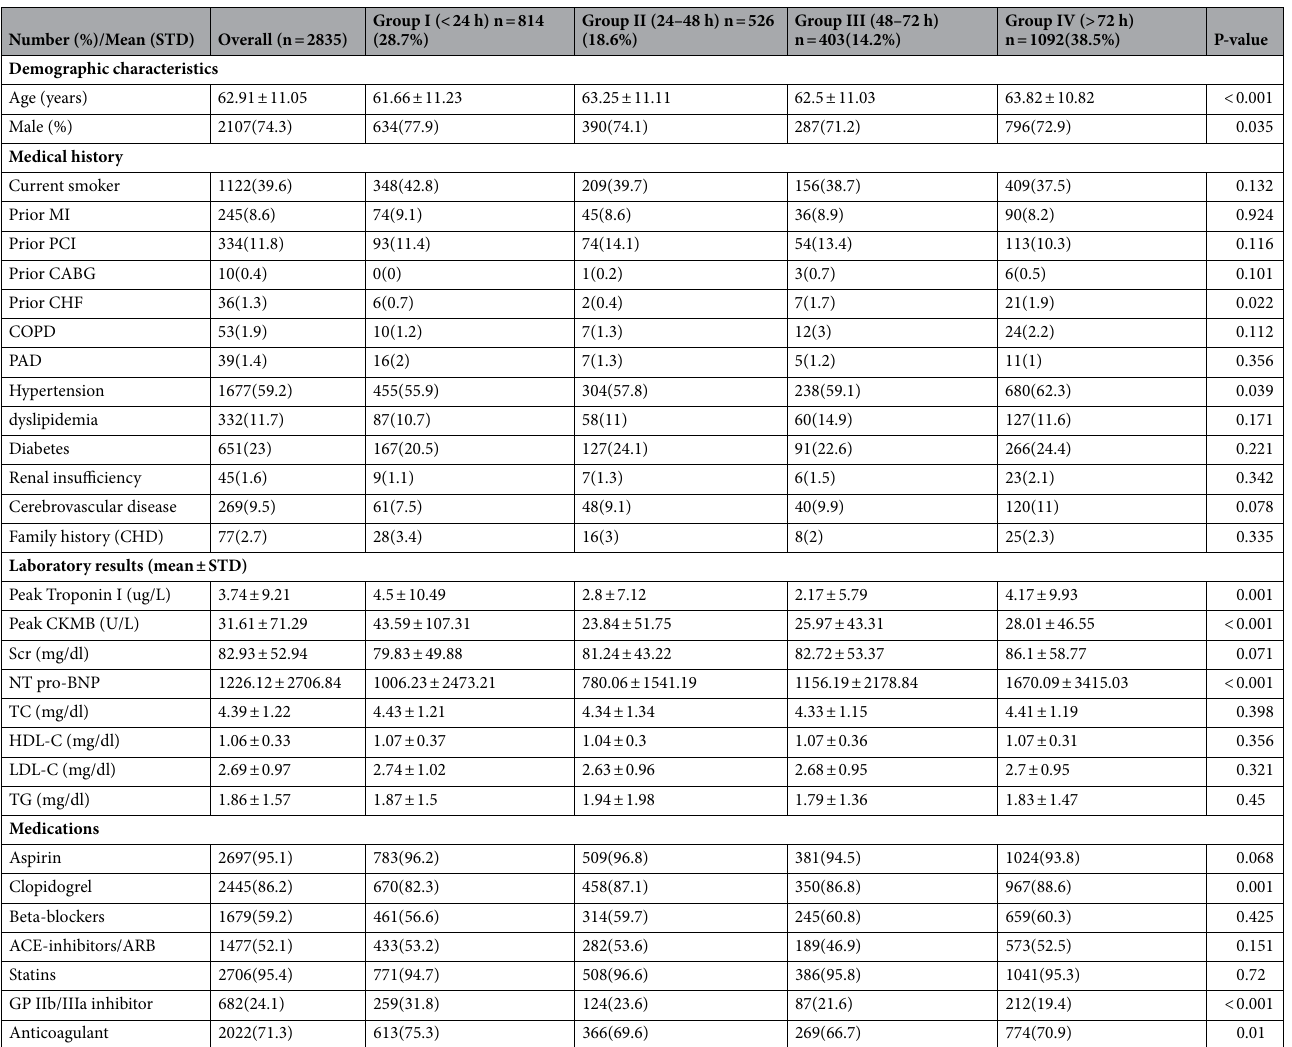
Table 1. Baseline characteristics of patients. MI myocardial infarction, PCI percutaneous coronary intervention, CABG coronary artery bypass graft surgery, CHF congestive heart failure, PAD peripheral artery disease, CHD coronary heart disease, ACEI angiotension converting enzyme inhibitor, ARB angiotension receptor blocker.